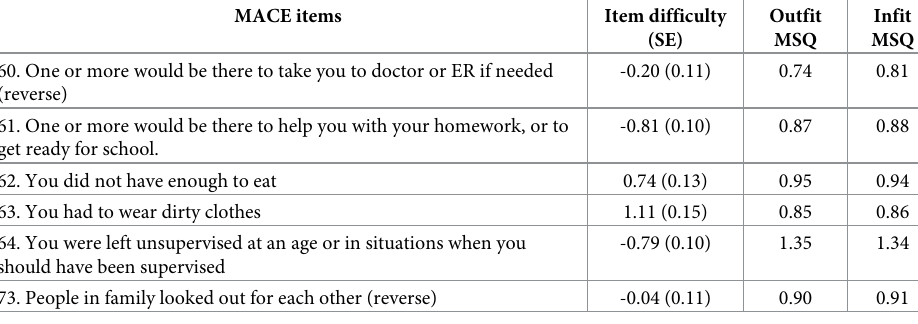
Table 10. Rasch analysis of physical neglect subscale.